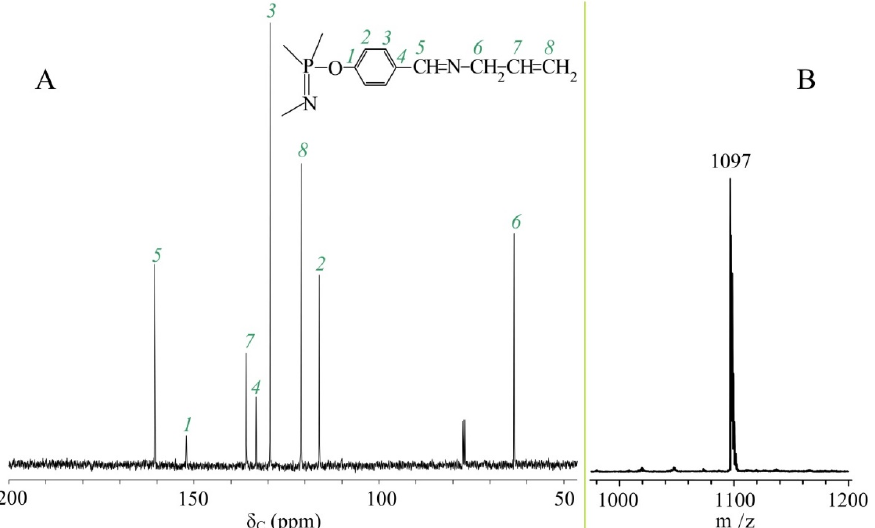
Figure 3. 13 C NMR spectra ( A ) and MALDI-TOF mass spectra ( B ) of APP.